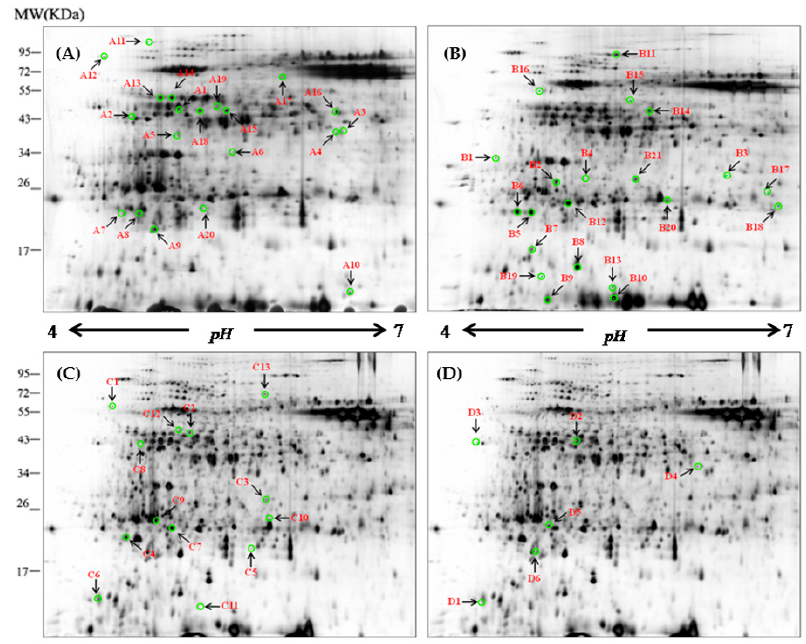
Figure 1. Representative two-dimensional gel electrophoresis (2-DE) maps of barley leaf proteins in XZ5. The proteins were isolated from the leaf of XZ5 exposed to drought ( A ), salinity alone ( B ), and